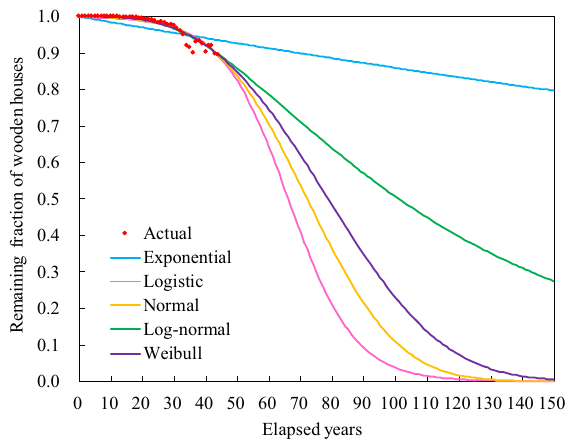
Figure 1. Estimated lifetime functions of wooden houses. Note : “Actual” indicates the actual remaining fraction calculated based on the number of existing and built wooden houses (see the “Flux data method” section). “Exponential,” “Logistic,” “Normal,” “Log-normal,” and “Weibull” represent the estimated remaining fraction based on parameters that minimize the residual sum of squares (RSS) between the actual values and the estimated values for each lifetime function.